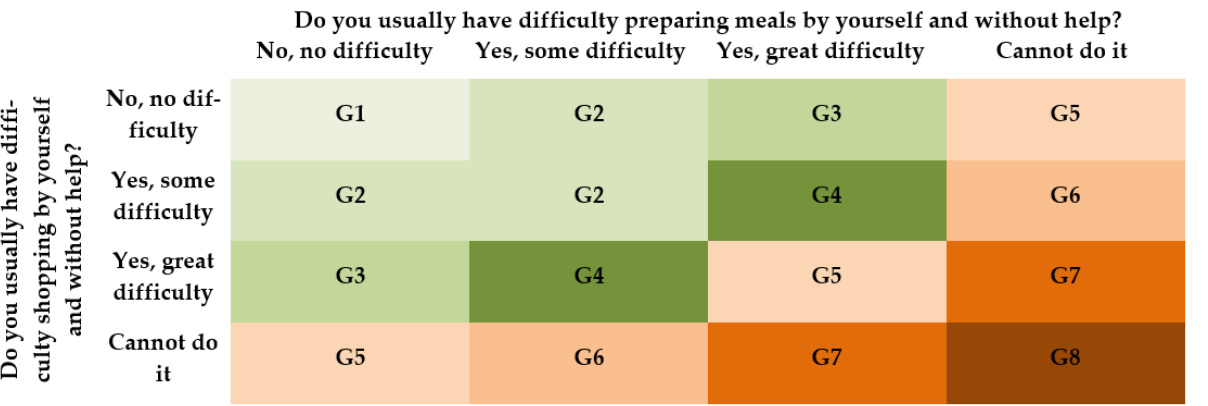
Figure 1. Groups according to difficulty in shopping and preparing meals. Colours identify groups: G1 (light green), G2 (medium green), G3 (moderate dark green), G4 (dark green), G5 (light brown), G6 (medium brown), G7 (moderate dark brown), G8 (dark brown). Source: compiled by the authors. Question 42.A is included in the horizontal axis and question 42.C in the vertical one, EHSS. The calculation of the indicator’s sampling error (s.e. (IAFA)) was carried out as fol- lows: